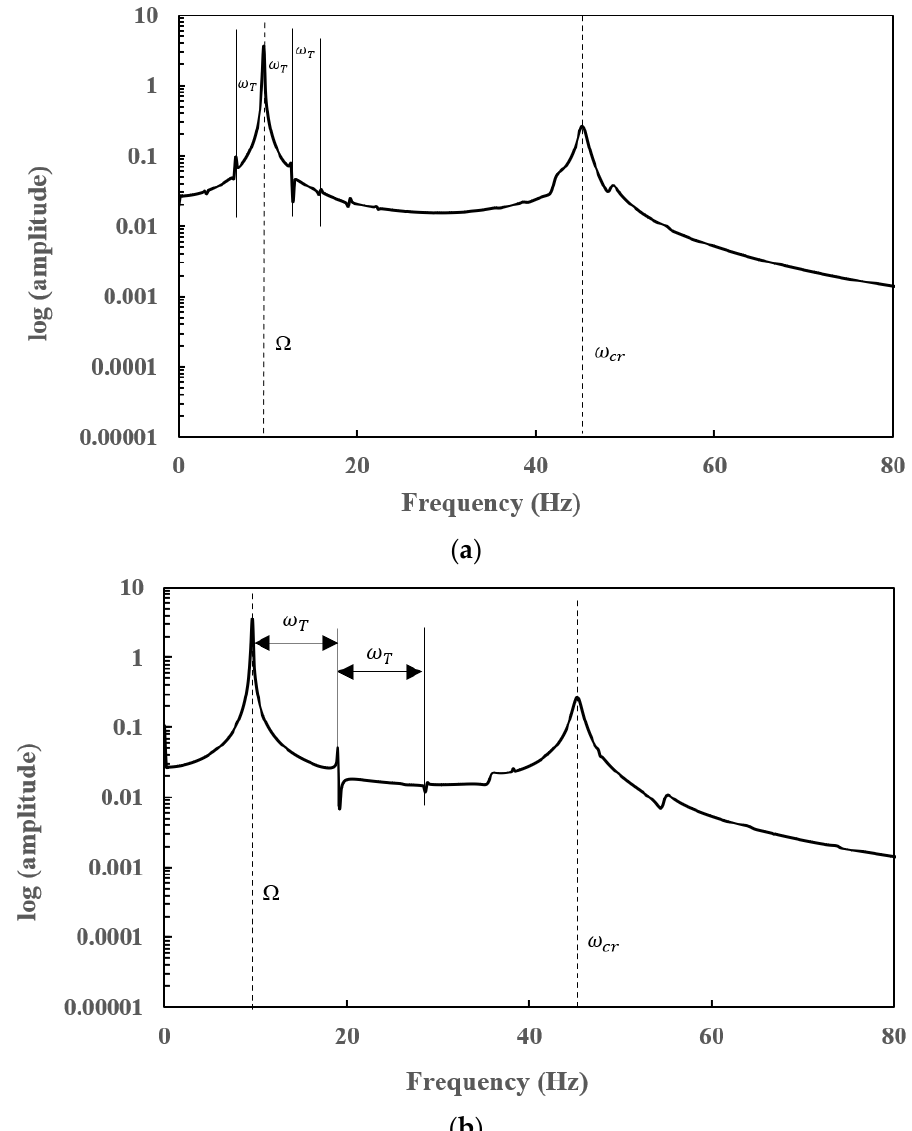
Figure 11. Steady-state FFT of a slant-cracked EG rotor-bearing system with a rotor speed of 60 rad/s with α = 0.3 for torsional frequency ( a ) ω T = 20 rad/s ( b ) ω T = 60